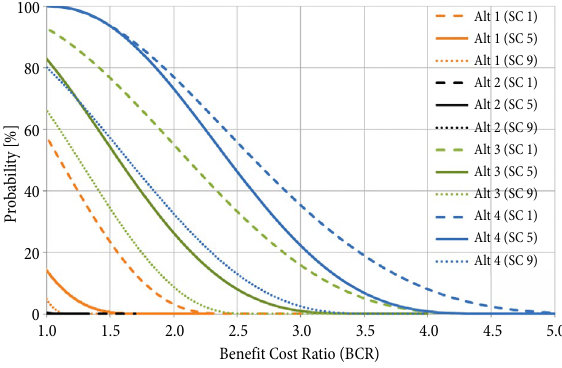
Fig. 8. Certainty graphs from the reference scenario forecasting